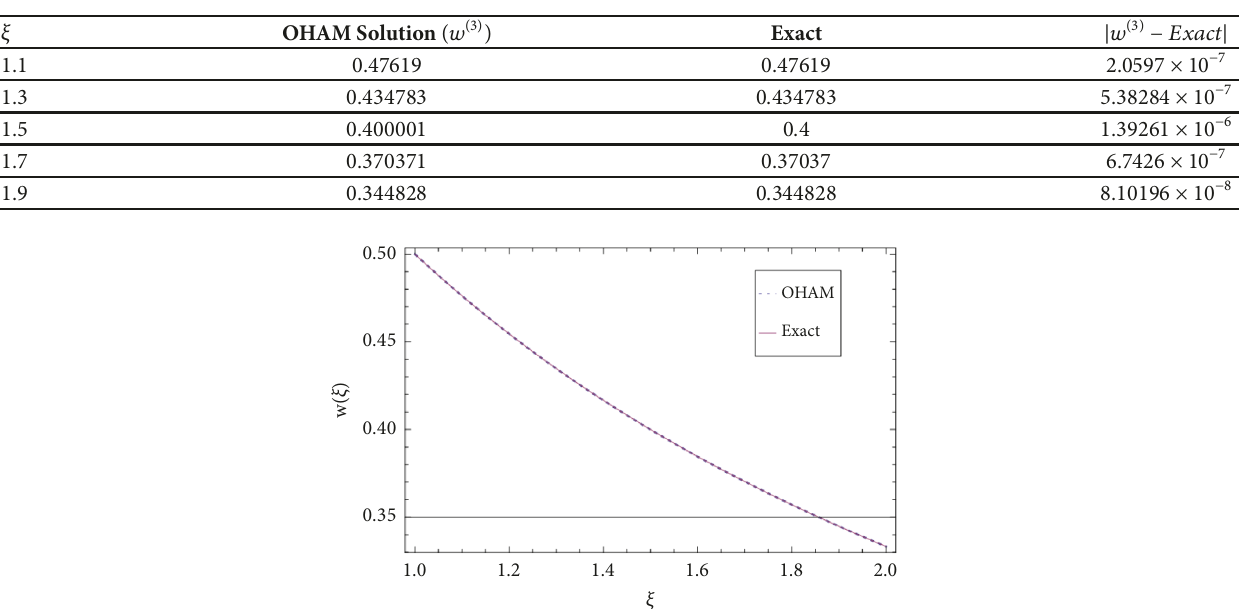
Table 2: Comparison of second-order OHAM solution with the exact solution for example 2.